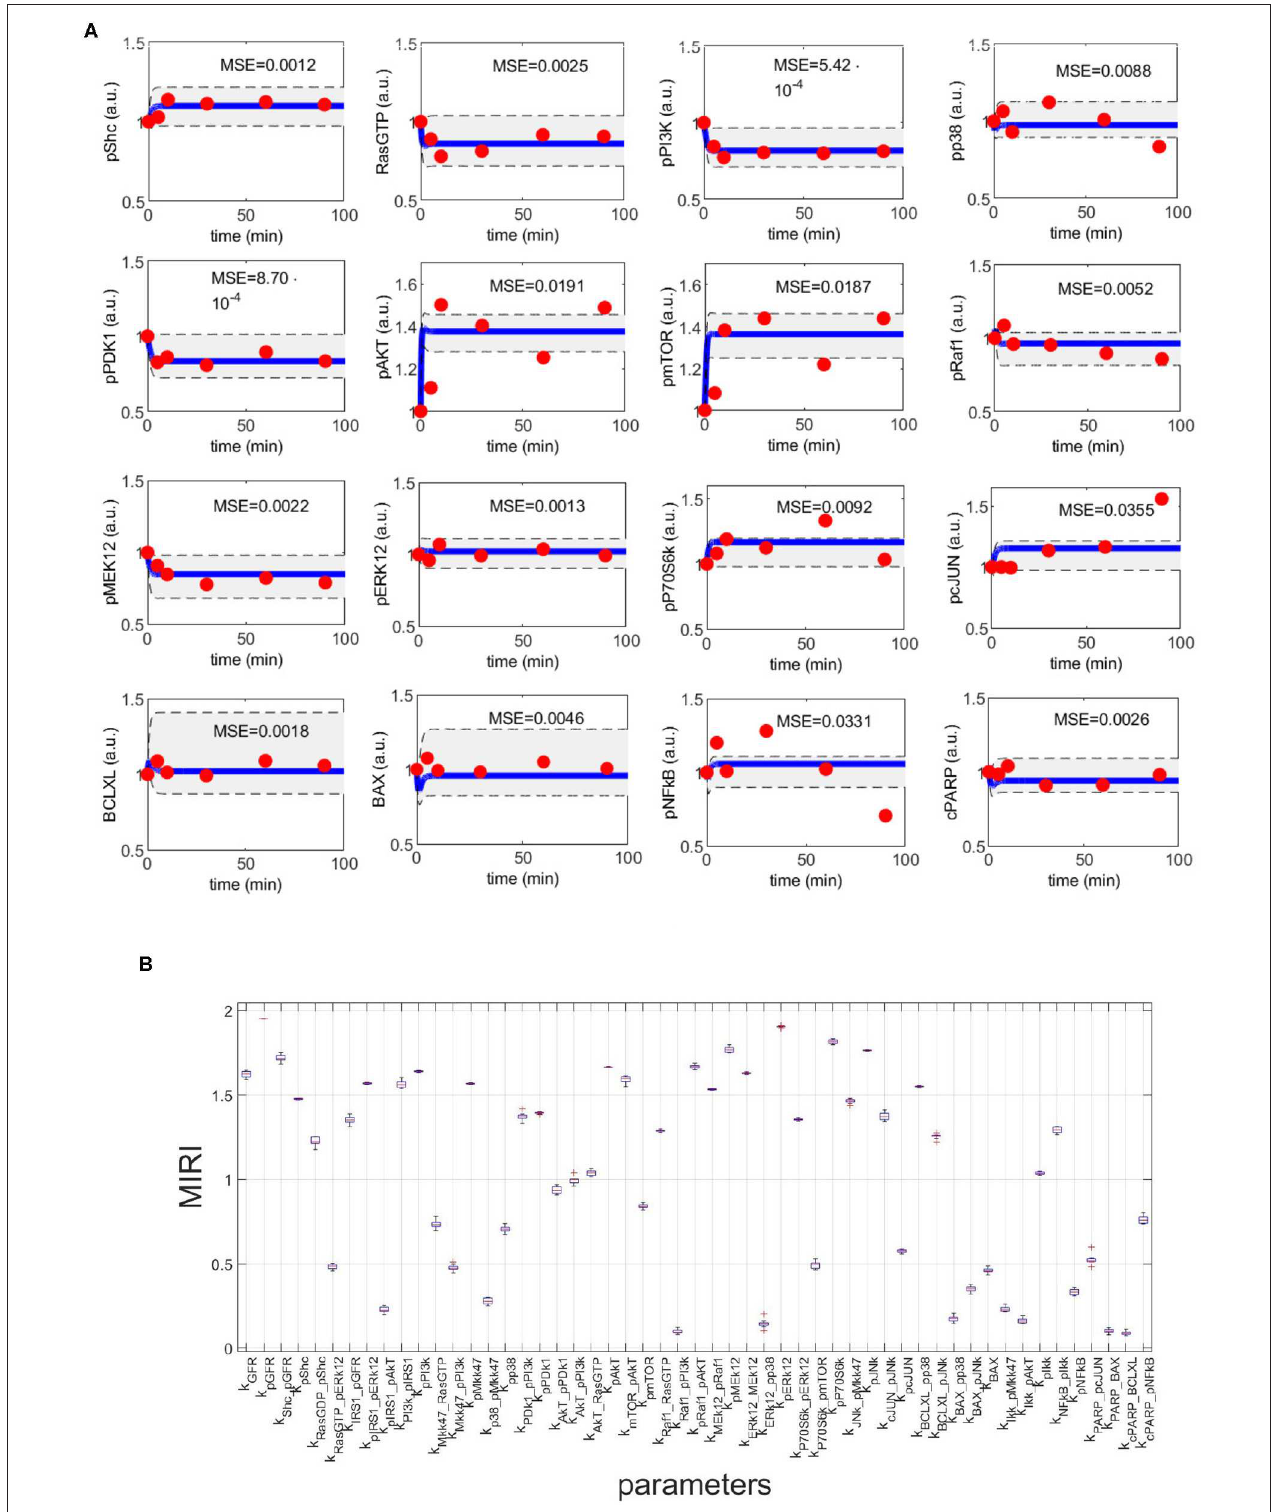
FIGURE 4 | CRC results for model M3. (A) The blue line is the time behavior of observables when the parameter vector is equal to p 6 m (see Table S25 ); red dots are the RPPA data [46]; the gray area reproduces the variation of the temporal behavior when parameters vary between the 2.5-th and 97.5-th percentile of their corresponding conditional pdfs f P | P ( p ). On the top of each plot, the MSE between the associated model simulation and the data is reported. (B) Boxplot of MIRIs S , ǫ 6 for the estimated parameter values, along the 10 independent realizations performed.